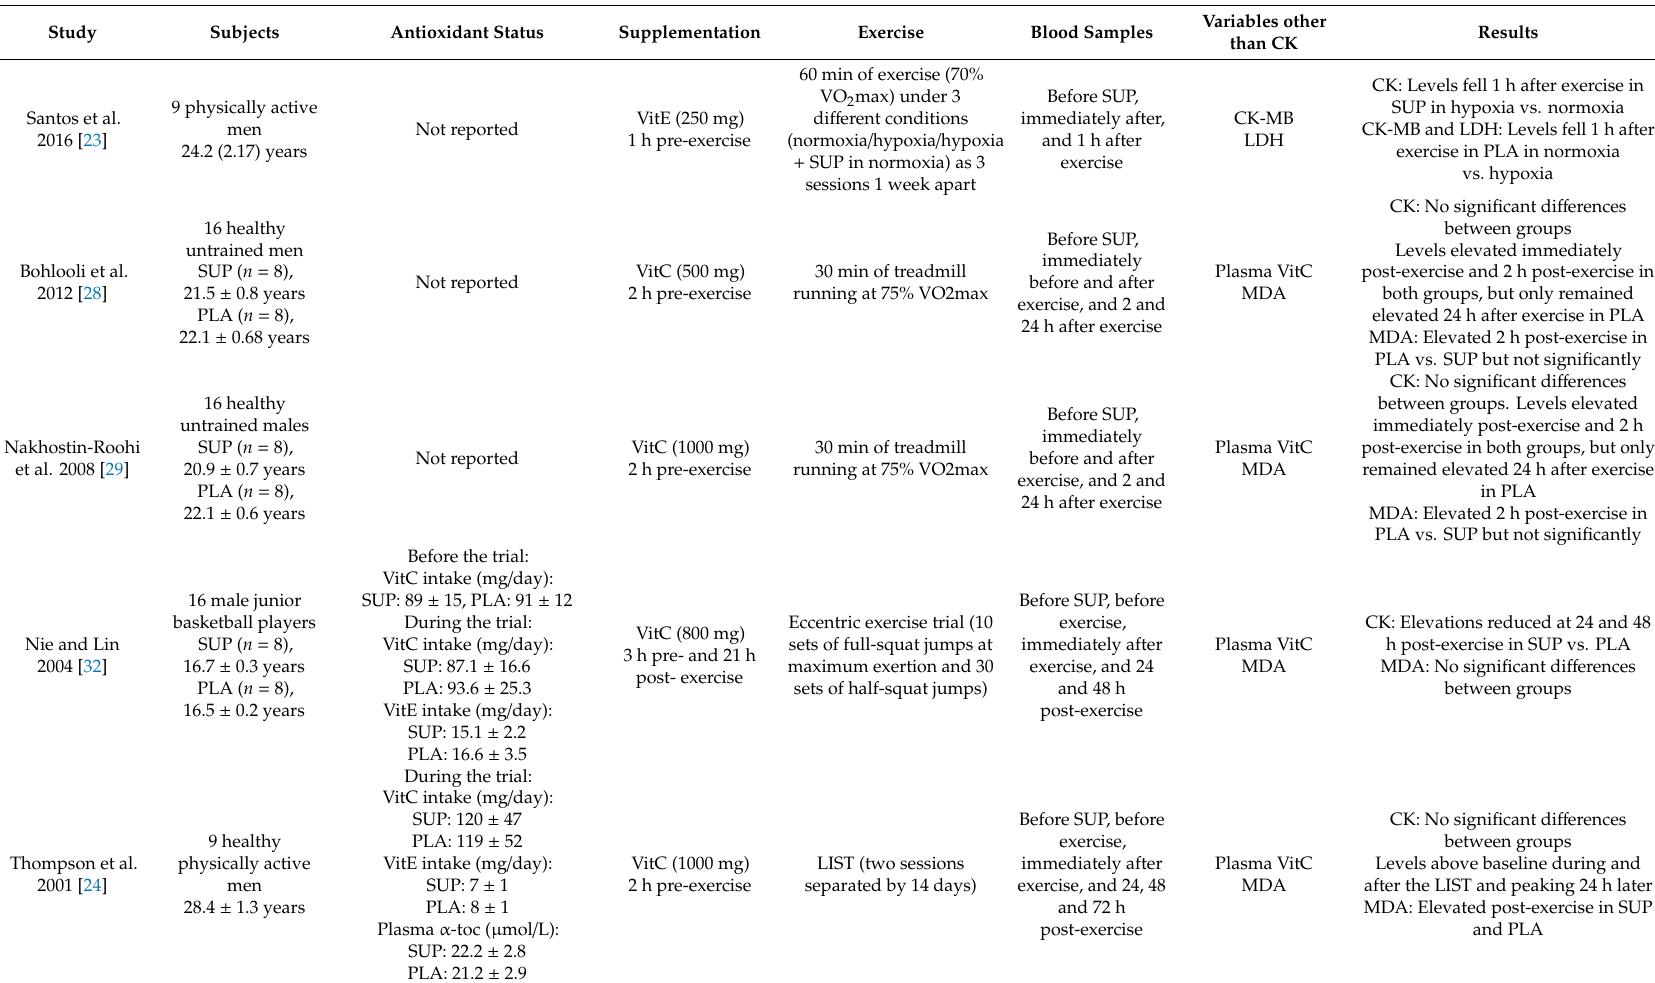
Table 2. Summary of the studies reviewed examining the e ff ects of an acute dose of VitC or VitE in a single exercise